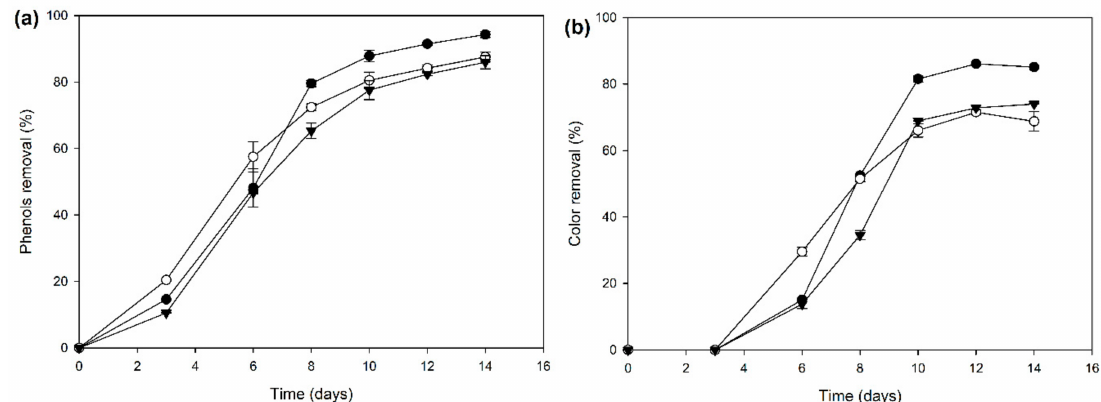
Figure 3. OMWW degradation during growth of P. citrinopileatus ( black circles ), A. biennis ( white circles ) and G. resinaceum ( black inverted triangles ), on OMWW. ( a ) Removal of phenols, ( b ) decolorization.